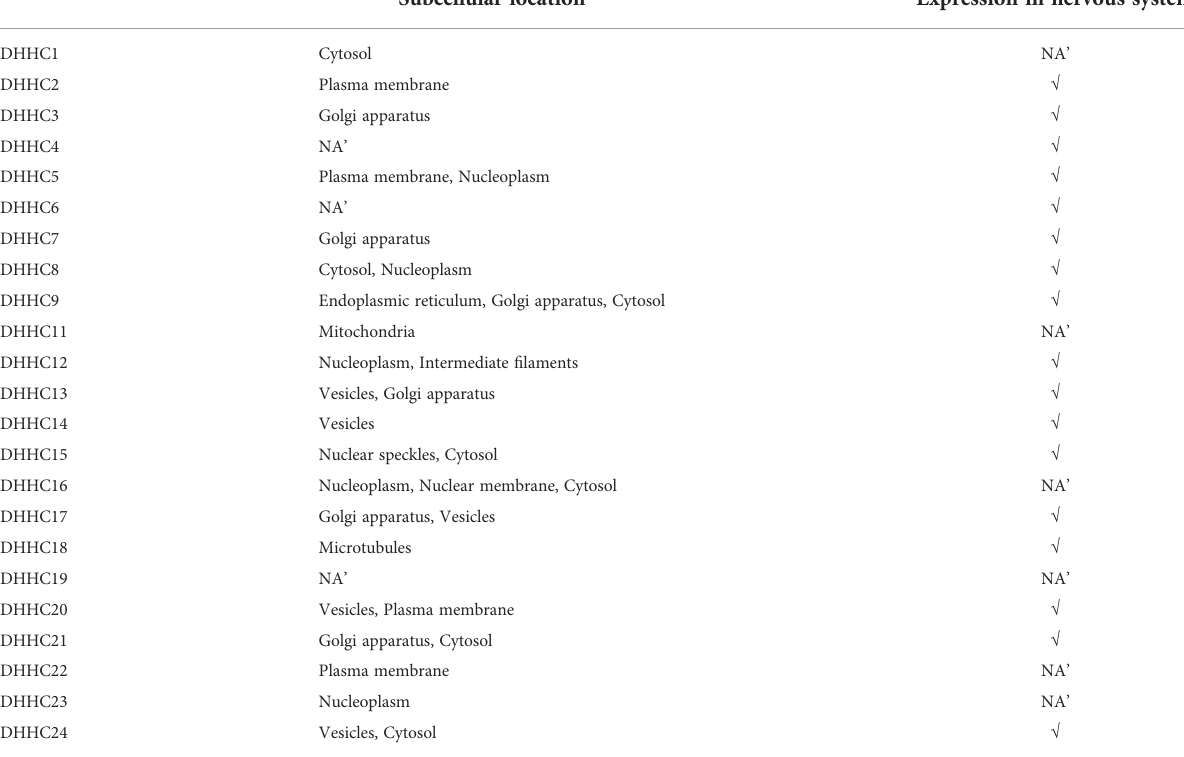
TABLE 1 The subcellular location and nervous system expression of ZDHHCs. (The HPA database). Subcellular